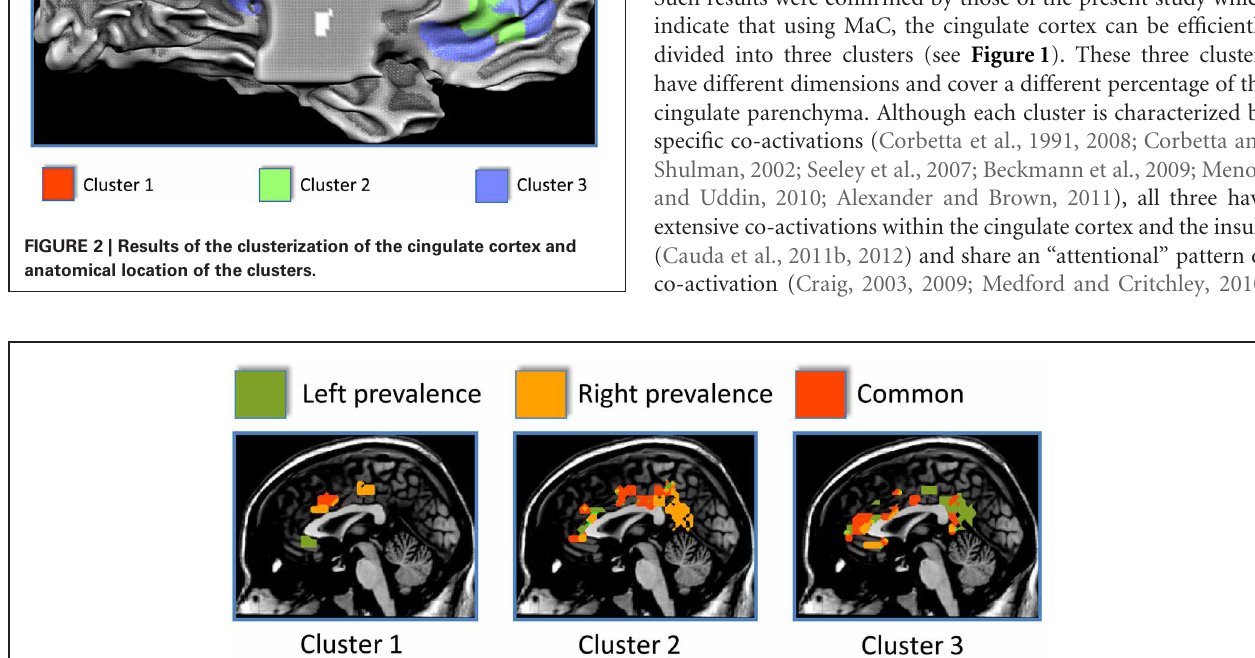
Frontiers in Human